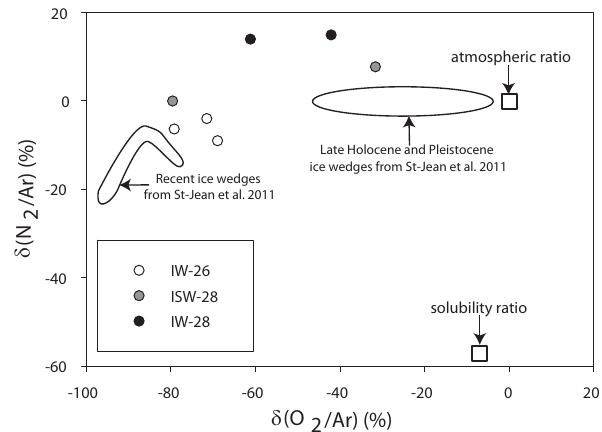
Fig. 8. δ (N 2 /Ar) and δ (O 2 /Ar) of ice wedges IW-26, ISW-28 and IW-28 using the following equation: δ (N 2 /Ar) = where “sa” refers to the sample and “st” to the standard value (stan- dards used are 22.43 and 83.60 for O 2 /Ar and N 2 /Ar, respectively). An equivalent formula is used for determining δ (O 2